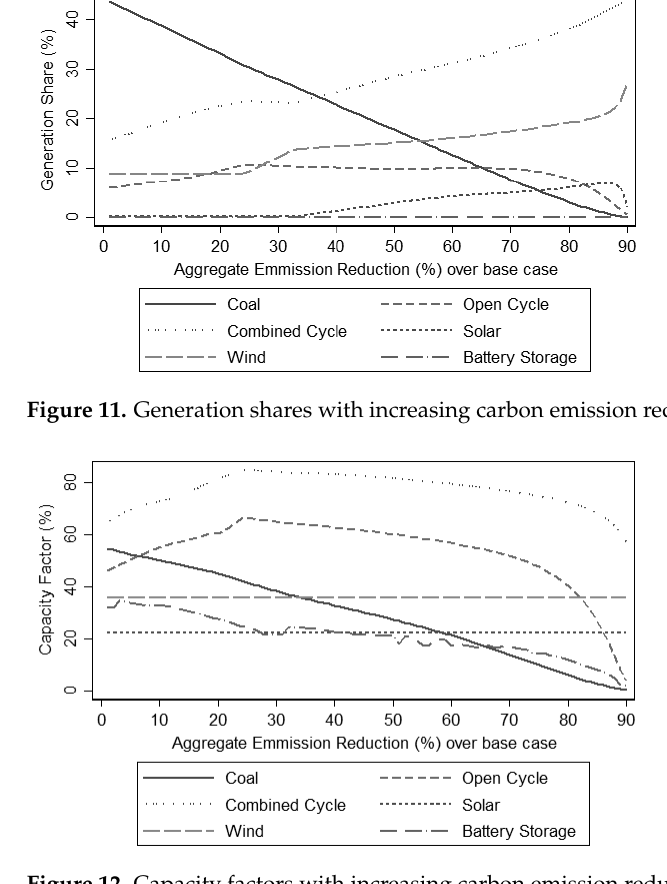
Figure 12. Capacity factors with increasing carbon emission reduction target.